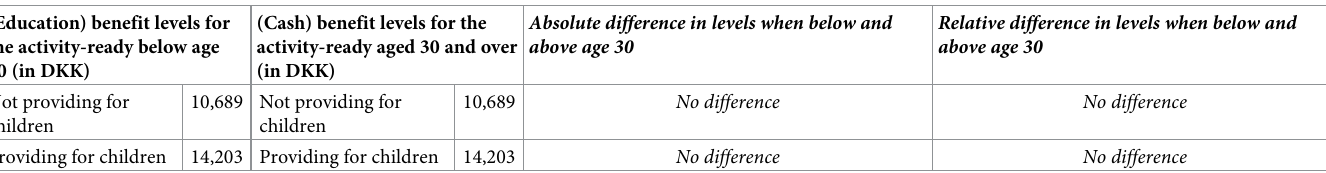
The table presents the monthly benefit levels for activity-ready young adult by parenthood and age. The table shows the absolute and relative differences in benefit levels prior to and after turning 30. Source: Own calculations based on The Danish Ministry of Employment